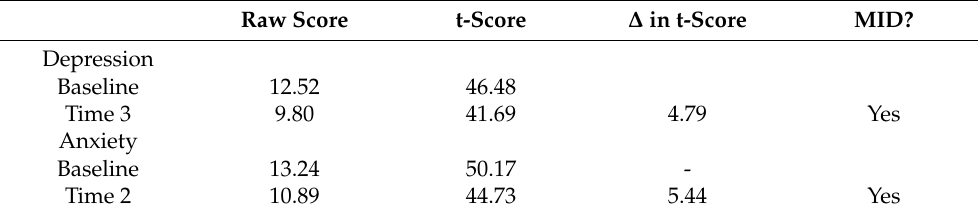
Table 3. Results interpreted in the context of t-scores and minimally important differences. Raw Score t-Score ∆ in t-Score MID? Depression Baseline 12.52 46.48 Time 3 9.80 41.69 4.79 Baseline 13.24 50.17 - 10.89